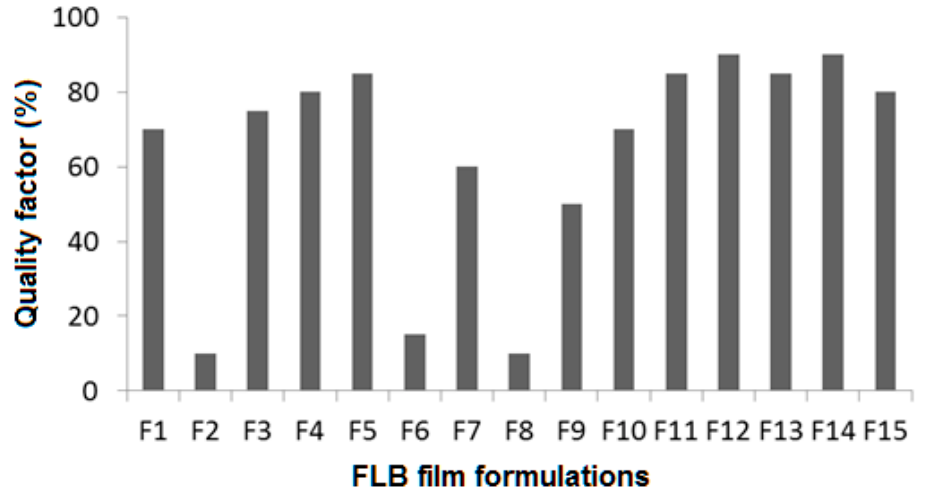
Figure 14. QF (%) for FLBFDOFs formulations.